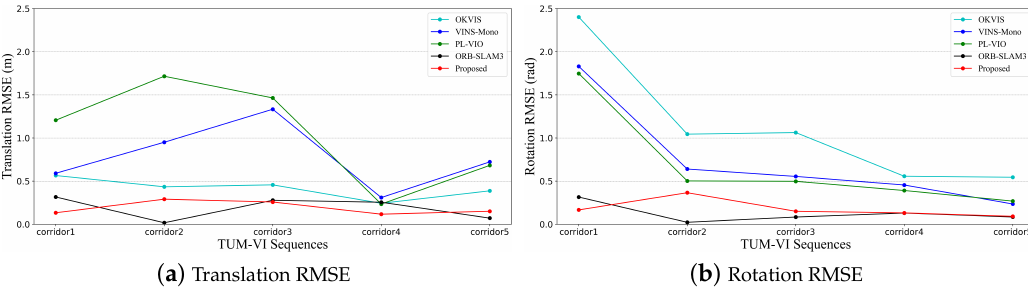
Figure 9. The line charts represent root mean square error (RMSE) of translation and rotation in the TUM-VI